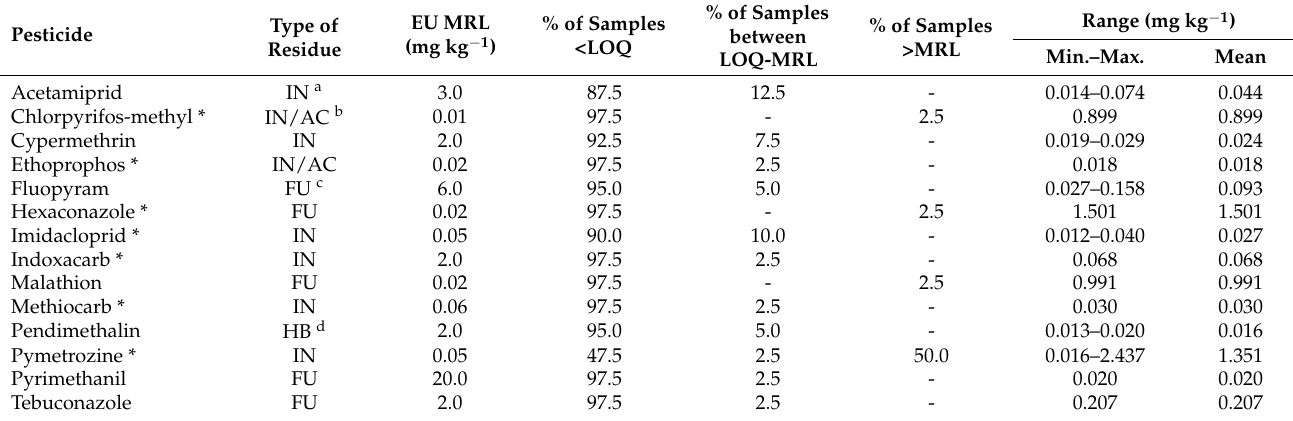
Table 4. The presence and quantification of pesticide residues in parsley.